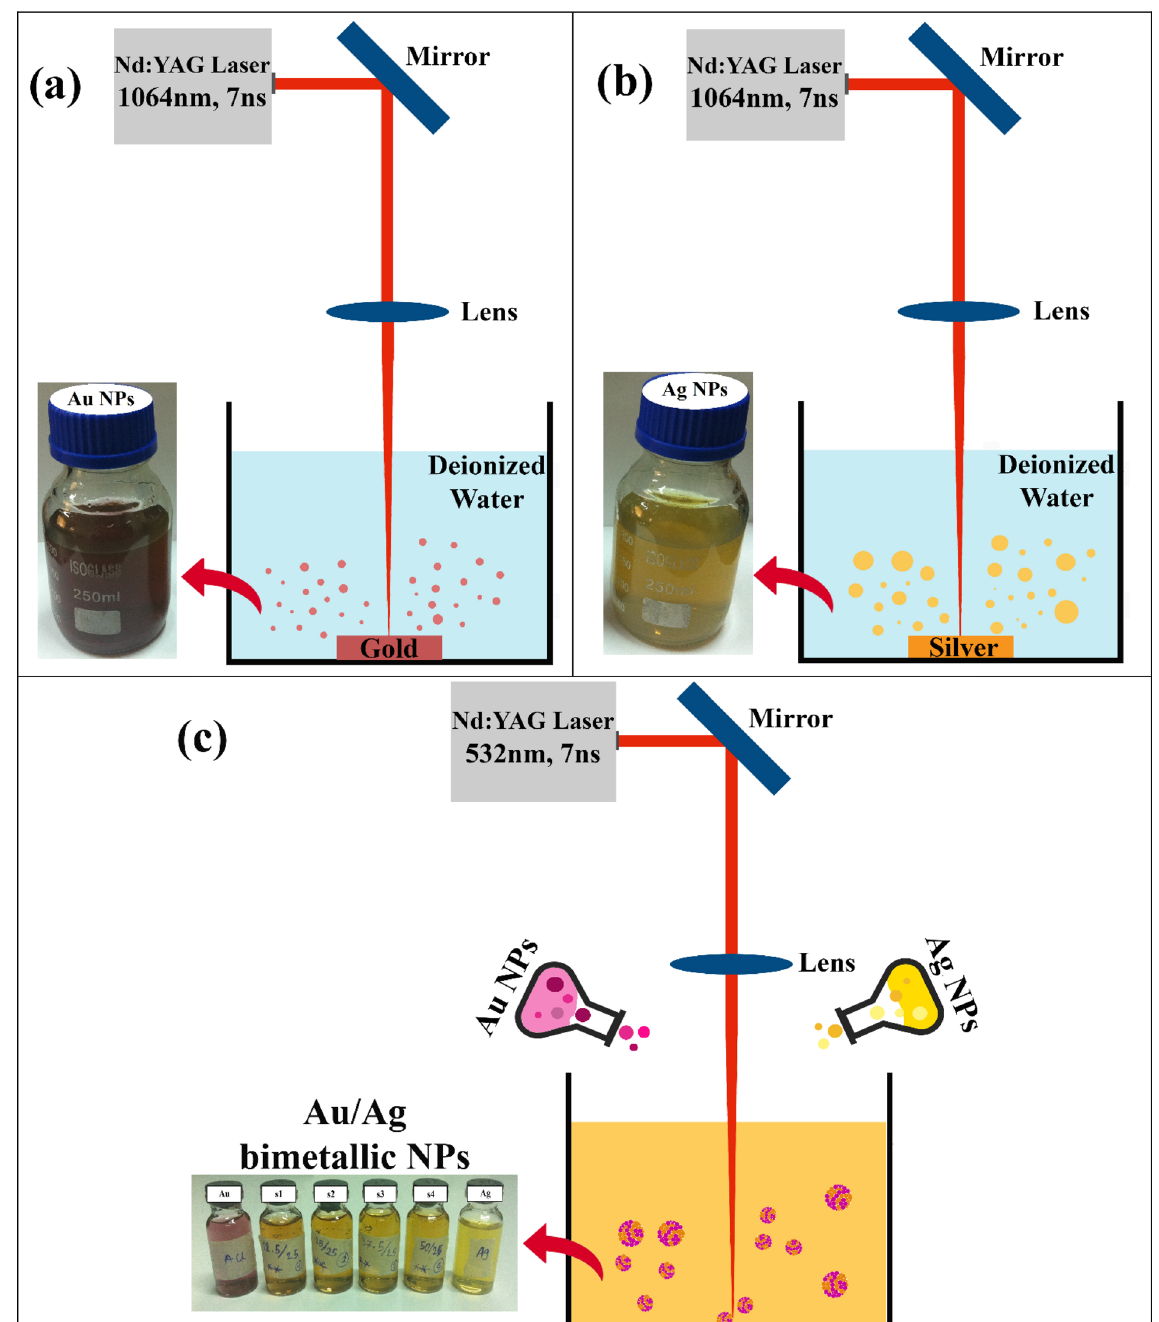
Fig. 2 Schematic of the laser ablation process. Show synthesize Au and AgNPs individually by first harmonic irradiation (1064 nm) a and b and illustrate formatting Au/Ag BNPs by green laser irradiation (532 nm)